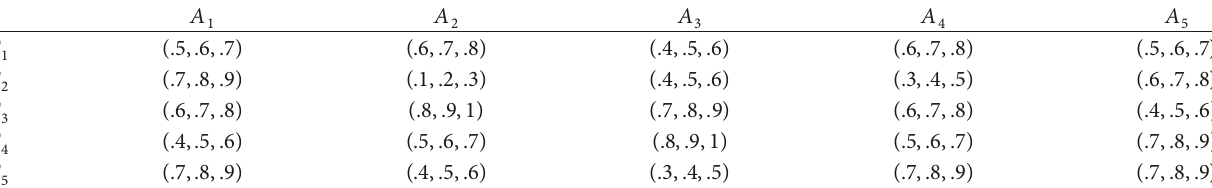
Table 3: Fuzzy decision matrix of expert 3.